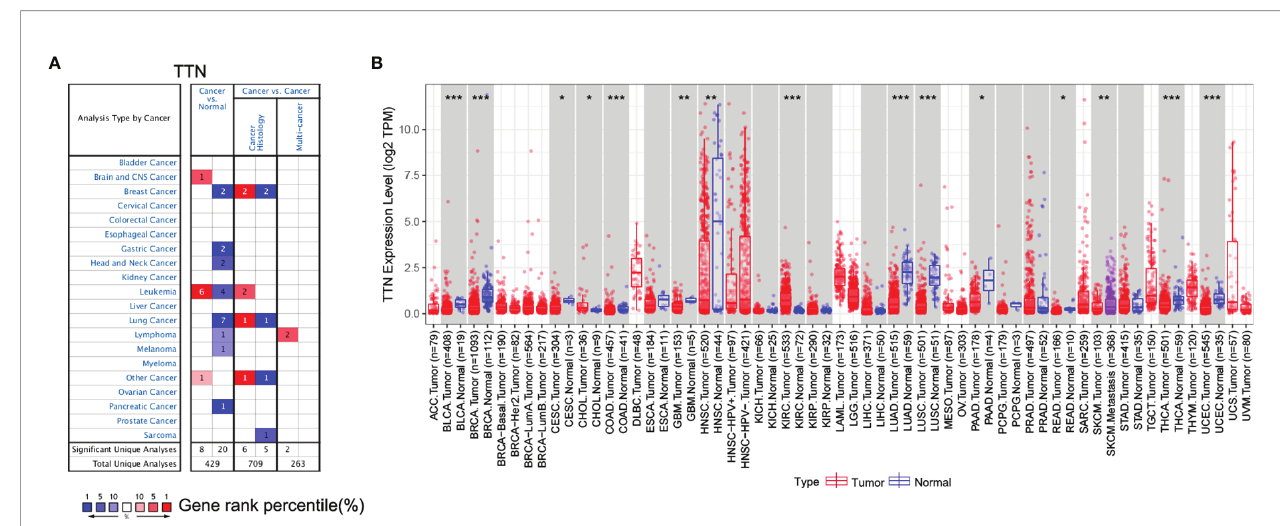
FIGURE 1 | TTN gene expression level in different cancer and normal tissues. (A) The expression level of TTN in different cancer and normal tissues in the Oncomine database. Cell color was determined by the best gene rank percentile for the analyses within the cell; (B) The expression of TTN between tumor tissues and normal tissues in different cancer types in TIMER database (* P < 0.05, ** P < 0.01, *** P <